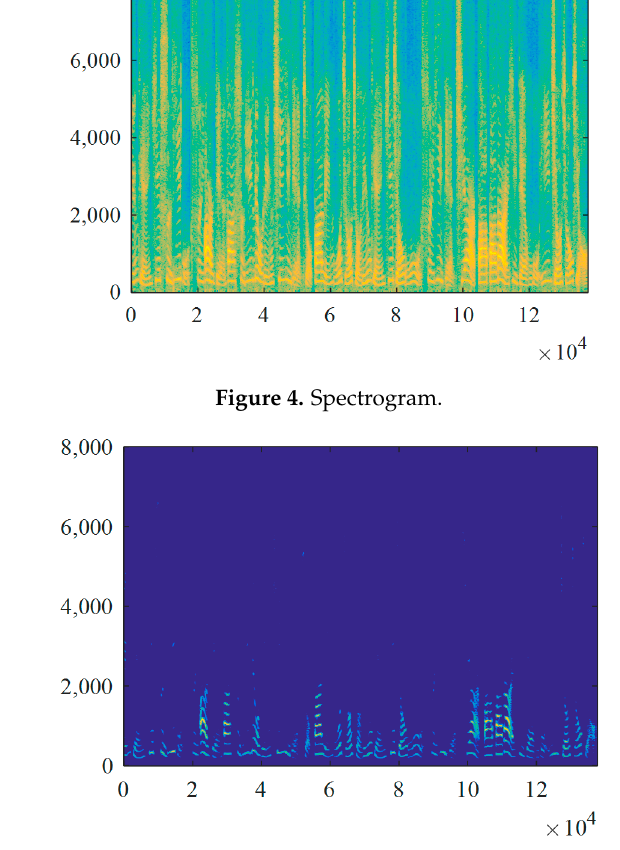
Figure 5. Pseudo-color spectrum.